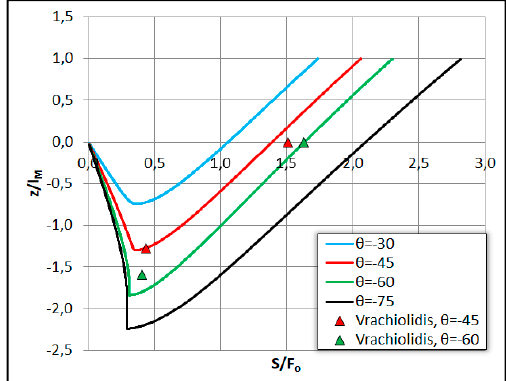
Figure 8. Comparison between model and experiments regarding the axial dilution S m /F o at terminal height and S r /F o at the return point of negatively buoyant heated